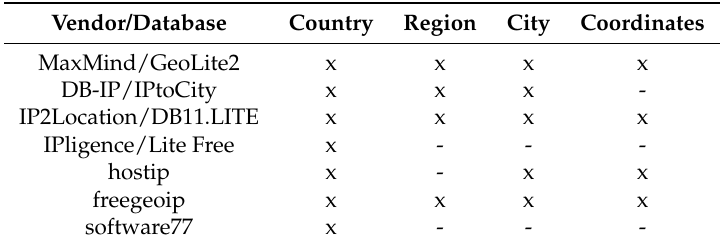
Table 3. Location information provided by IP geolocation